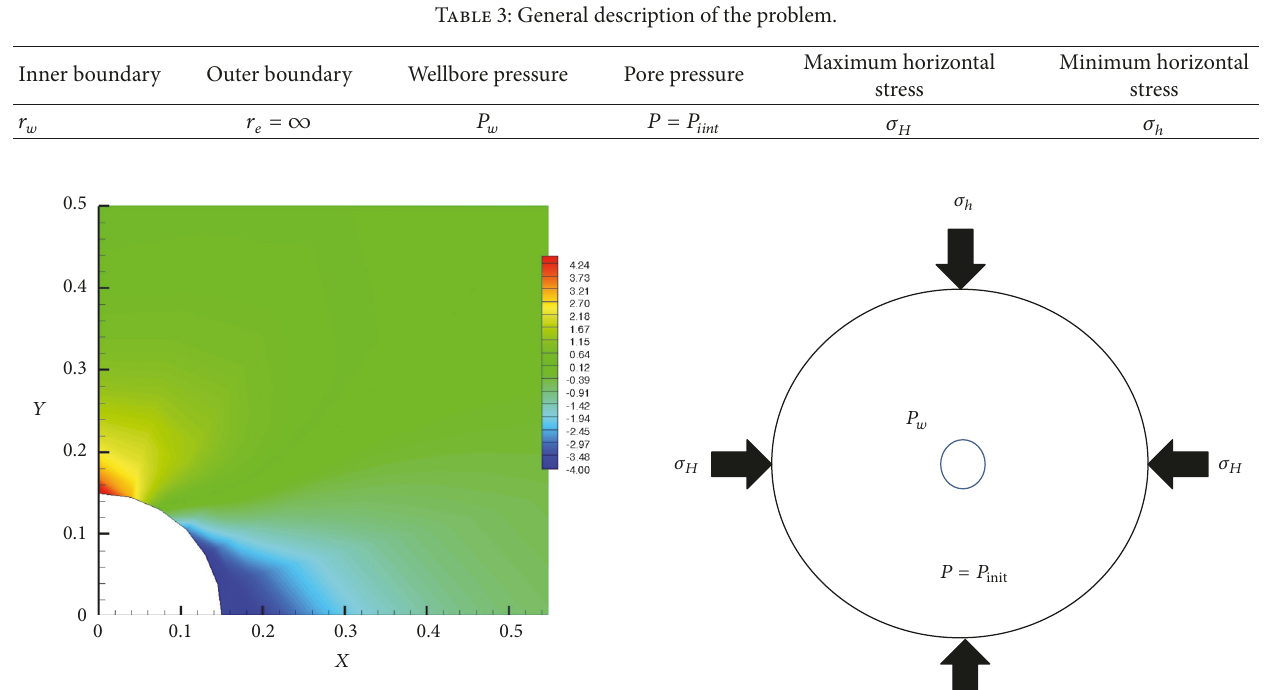
Figure 19: 𝑌 -component of net shear stresses at 𝑡 = 30s in poroelastic medium with 𝜎 𝐻 = 2436 psi and 𝜎 ℎ = 2030 psi, 𝑃 𝑟 =